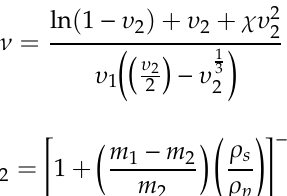
Composition and molecular weight distributions of pre-polymers. Poly(glycerol sebacate-co-butylene sebacate) (PGBS), poly(erythritol sebacate-co-butylene sebacate) (PEBS), poly(xylitol sebacate-co-butylene sebacate) (PXBS), poly(sorbitol sebacate-co-butylene sebacate) (PSBS), and poly(mannitol sebacate-co-butylene sebacate) (PMBS). Pre-Polymer